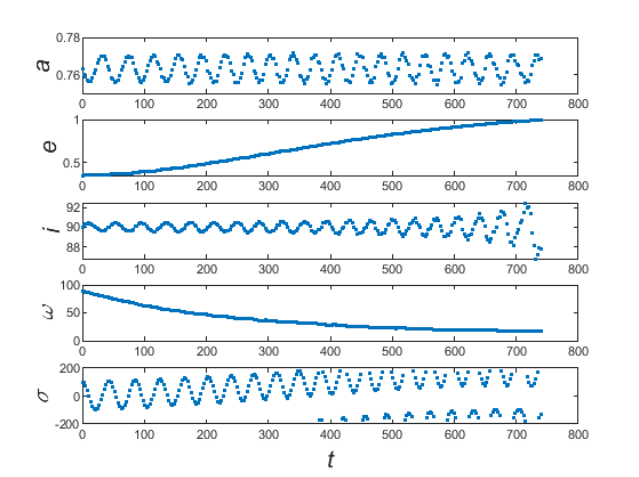
Figure 8. ( a ) Same as Figure 1, but for polar 2/3 resonance. Panel ( b , c ) are phase-space portraits of Kozai–Lidov dynamics on e − ω plane under exact 2/3 resonance with libration center σ = 0 ◦ and σ = 180 ◦ , respectively. The thick colored solid lines represent the numerical results. The solid black dots mark the initial positions of particles, and the arrows indicate the evolution direction of unstable particles.